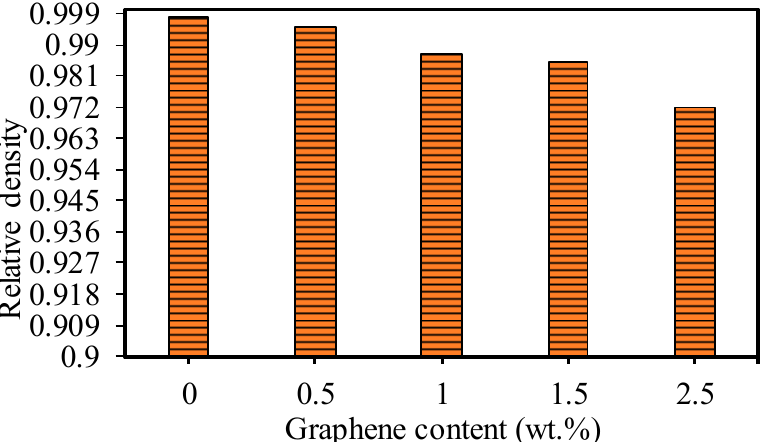
Figure 7. Relative density of the base Al 2 O 3 and GNP/Al 2 O 3 nanocomposites with different GNP